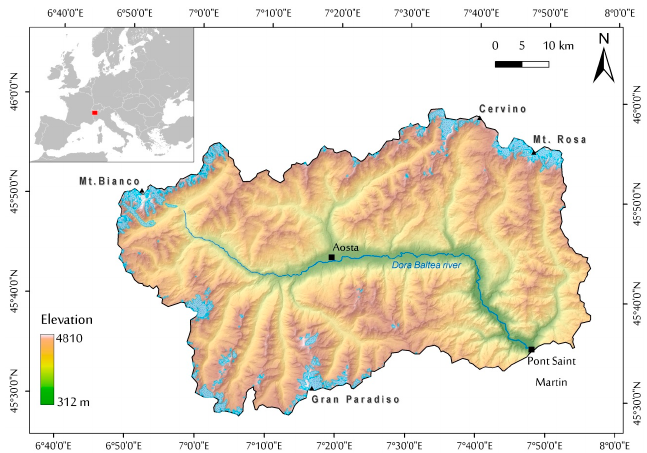
Figure 1. Relief terrain of the study area (the Valle d’Aosta (VDA) region, Northwestern Italy). The map shows the high and complex morphology of this mountainous area; the light blue polygons correspond to the present glaciers of the region, modified from the Glacier map of Fondazione Montagna Sicura [54]. From a geological point of view, the VDA region is part of the alpine chain [55–59], passing